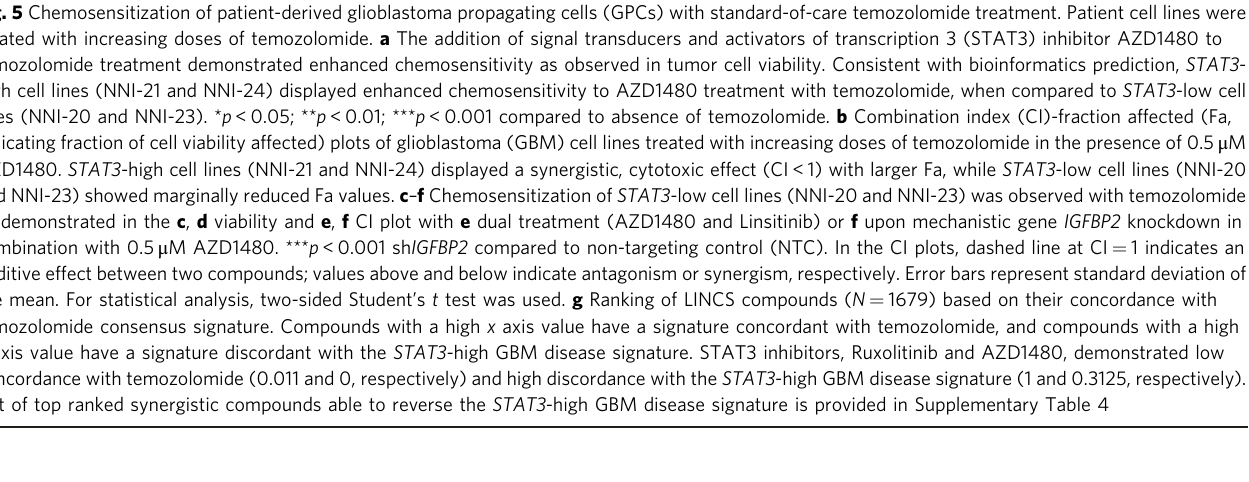
Fig. 5 Chemosensitization of patient-derived glioblastoma propagating cells (GPCs) with standard-of-care temozolomide treatment. Patient cell lines were treated with increasing doses of temozolomide. a The addition of signal transducers and activators of transcription 3 (STAT3) inhibitor AZD1480 to temozolomide treatment demonstrated enhanced chemosensitivity as observed in tumor cell viability. Consistent with bioinformatics prediction, STAT3 - high cell lines (NNI-21 and NNI-24) displayed enhanced chemosensitivity to AZD1480 treatment with temozolomide, when compared to STAT3 -low cell lines (NNI-20 and NNI-23). * p < 0.05; ** p < 0.01; *** p < 0.001 compared to absence of temozolomide. b Combination index (CI)-fraction affected (Fa, indicating fraction of cell viability affected) plots of glioblastoma (GBM) cell lines treated with increasing doses of temozolomide in the presence of 0.5 μ M AZD1480. STAT3 -high cell lines (NNI-21 and NNI-24) displayed a synergistic, cytotoxic effect (CI < 1) with larger Fa, while STAT3 -low cell lines (NNI-20